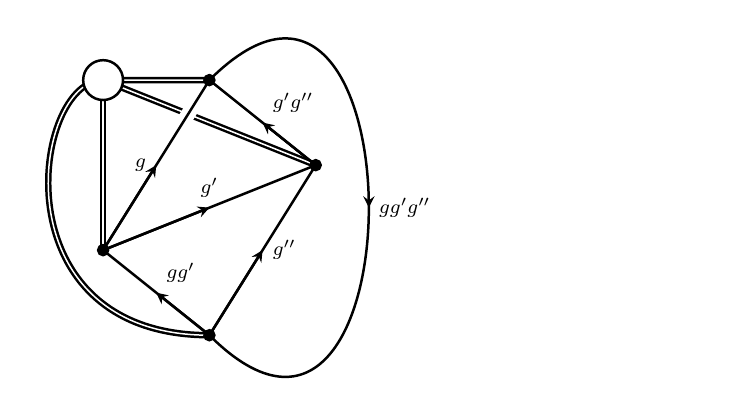
Figure 26 . Intermediate computational steps relating ^ (cid:11) 3 and (cid:23) 3 . The sign arises from dragging a (cid:5) line over a vertex. We can further resolve the crossing on the right hand side to make contact with (cid:23) 3 which is de(cid:12)ned in (cid:12)gure 27.